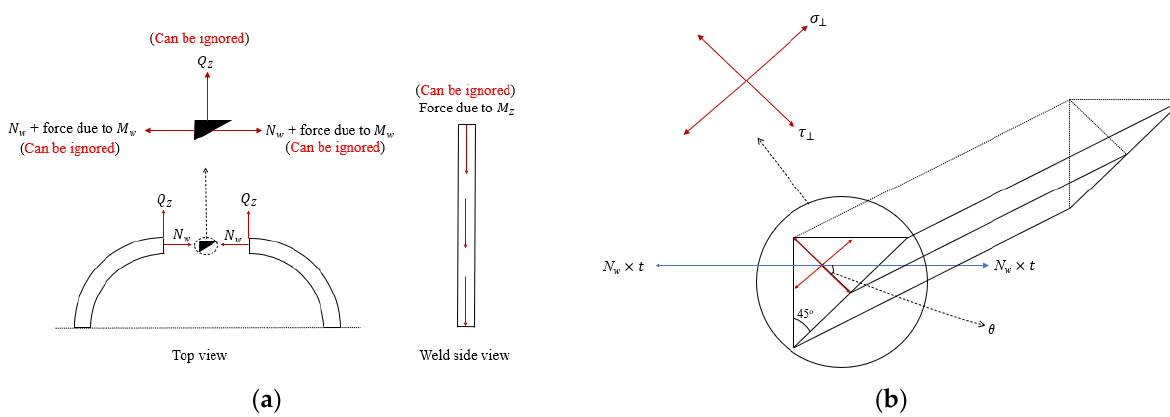
Figure 19. Stresses at the welded corner and the weld throat plane. ( a ) Reactions at the welded joint; ( b ) Reactions at the weld throat plane.